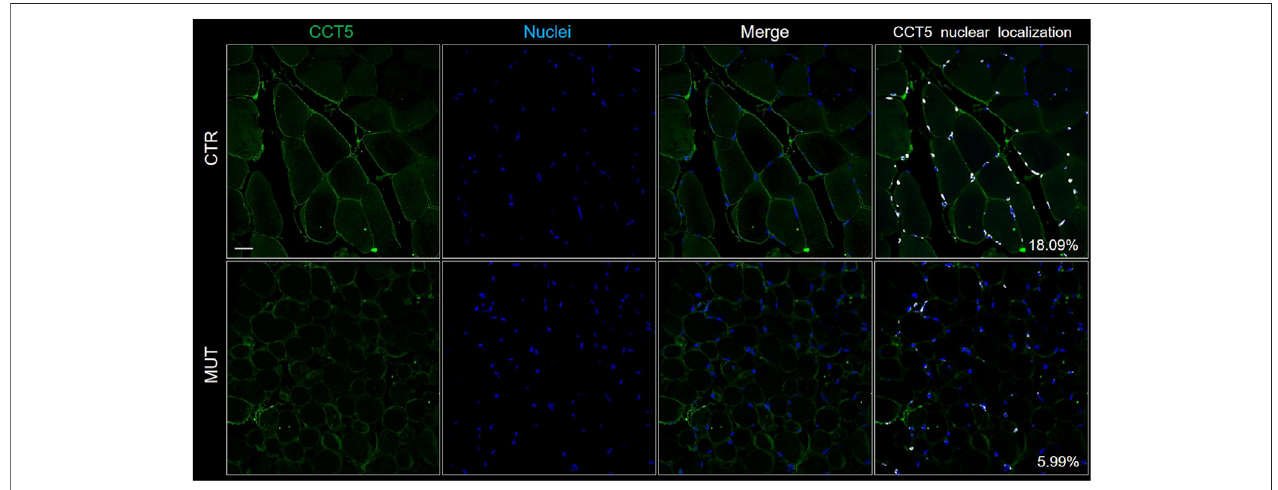
FIGURE3| LocalizationofCCT5onCTRandMUTmuscles.Immuno fl uorescencewasdonewithFITCconjugatedanti-CCT5antibody(green);nucleiwerestained withe Hoechst (blue). Nuclear localization of CCT5 (white spots) in CTR muscle (18.09%) was more frequent than in MUT muscle (5.99%). Bar = 25 μ m.